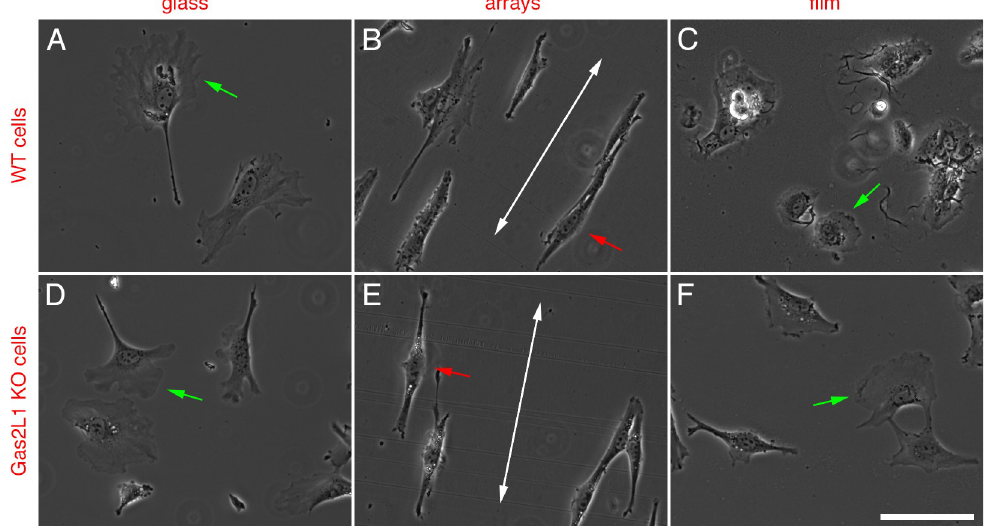
Fig 3. Morphology of wild-type and Gas2L1 KO Sertoli cells seeded on to glass, microgel arrays and films. Phase contrast images showing the morphology and orientation of control and Gas2L1 KO Sertoli cells on glass, microgel arrays and films. It is clear that cells on glass and microgel films demonstrate substantial spreading and the formation of lamellipodia (green arrows), whereas cells on microgel arrays are elongated with their major axis parallel to that of the array topography (red arrows). Large double headed arrows in B and E indicate the orientation of the arrays. Scale bars: 100 μ m.